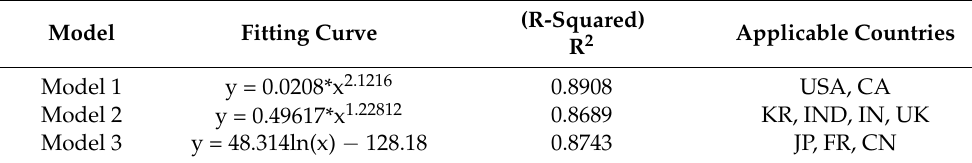
Table 1. Simulated models between urbanization and DWPC.